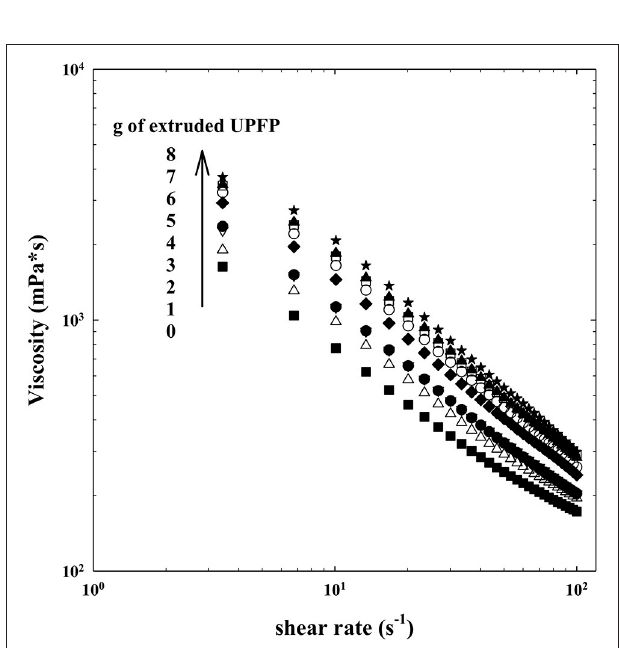
FIGURE 6 | Viscosity of yogurt added with extruded flour of unripe plantain pulp